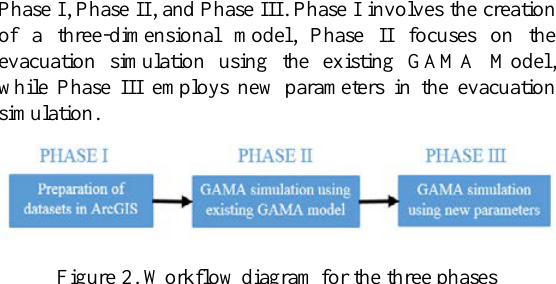
Figure 2. Workflow diagram for the three